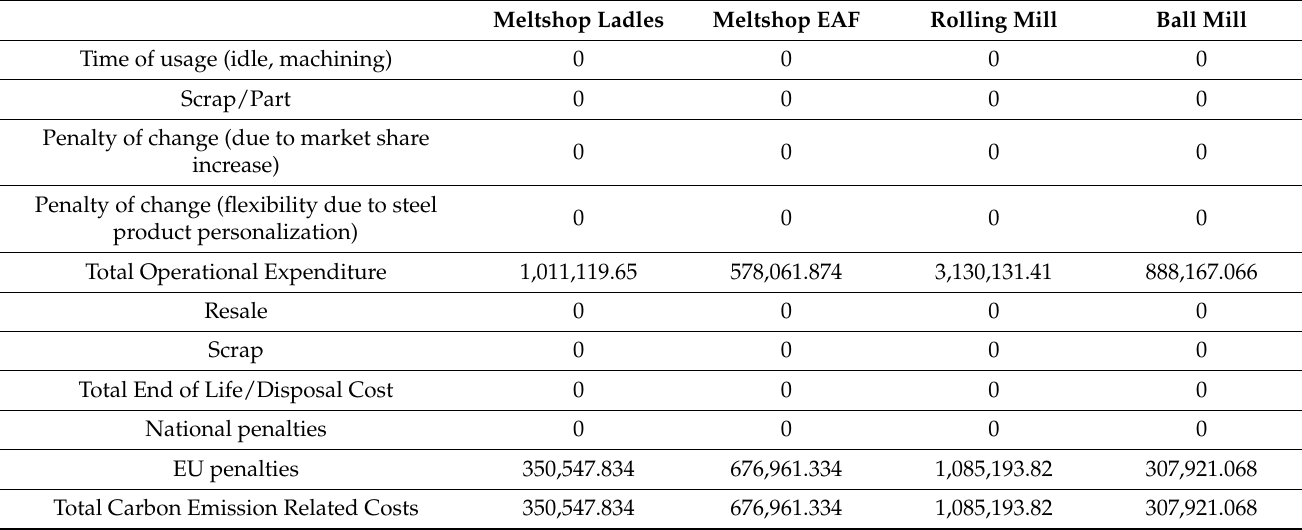
Table A3. Cont. Meltshop Ladles Meltshop